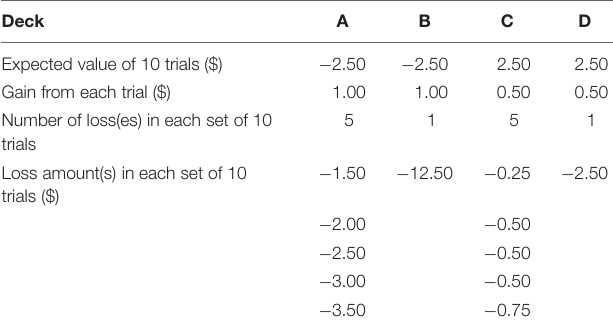
TABLE 1 | The payoff distribution of the